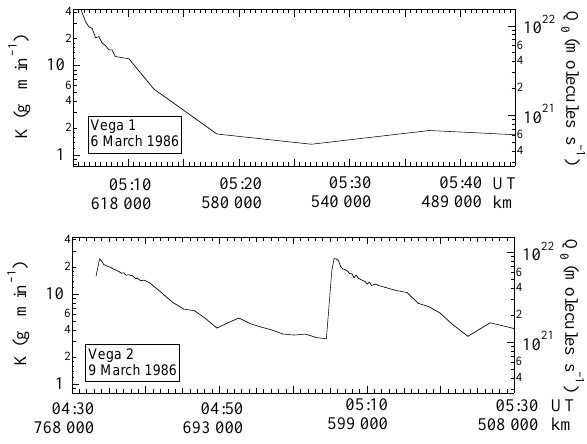
Fig. 3. Nitrogen gas release rates on Vega 1 and 2.